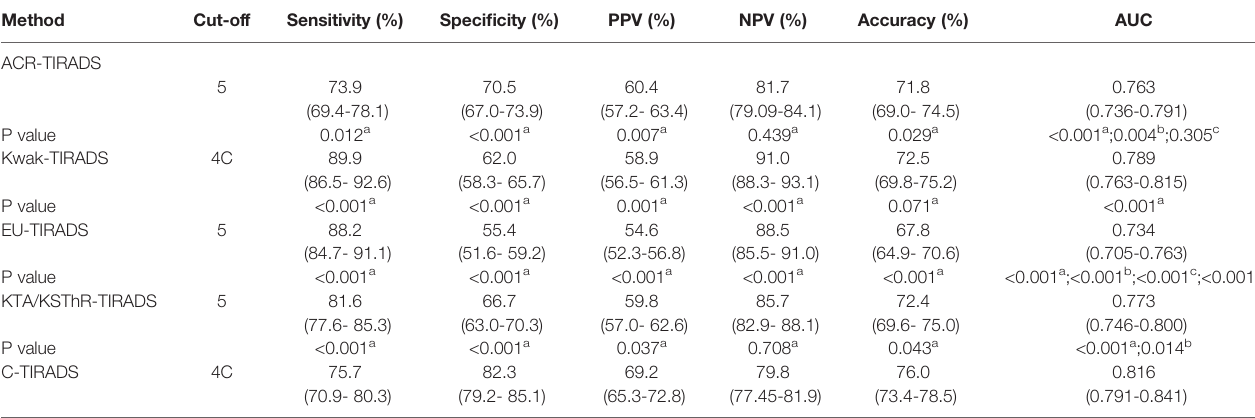
TABLE 3 | Diagnostic performance of 5